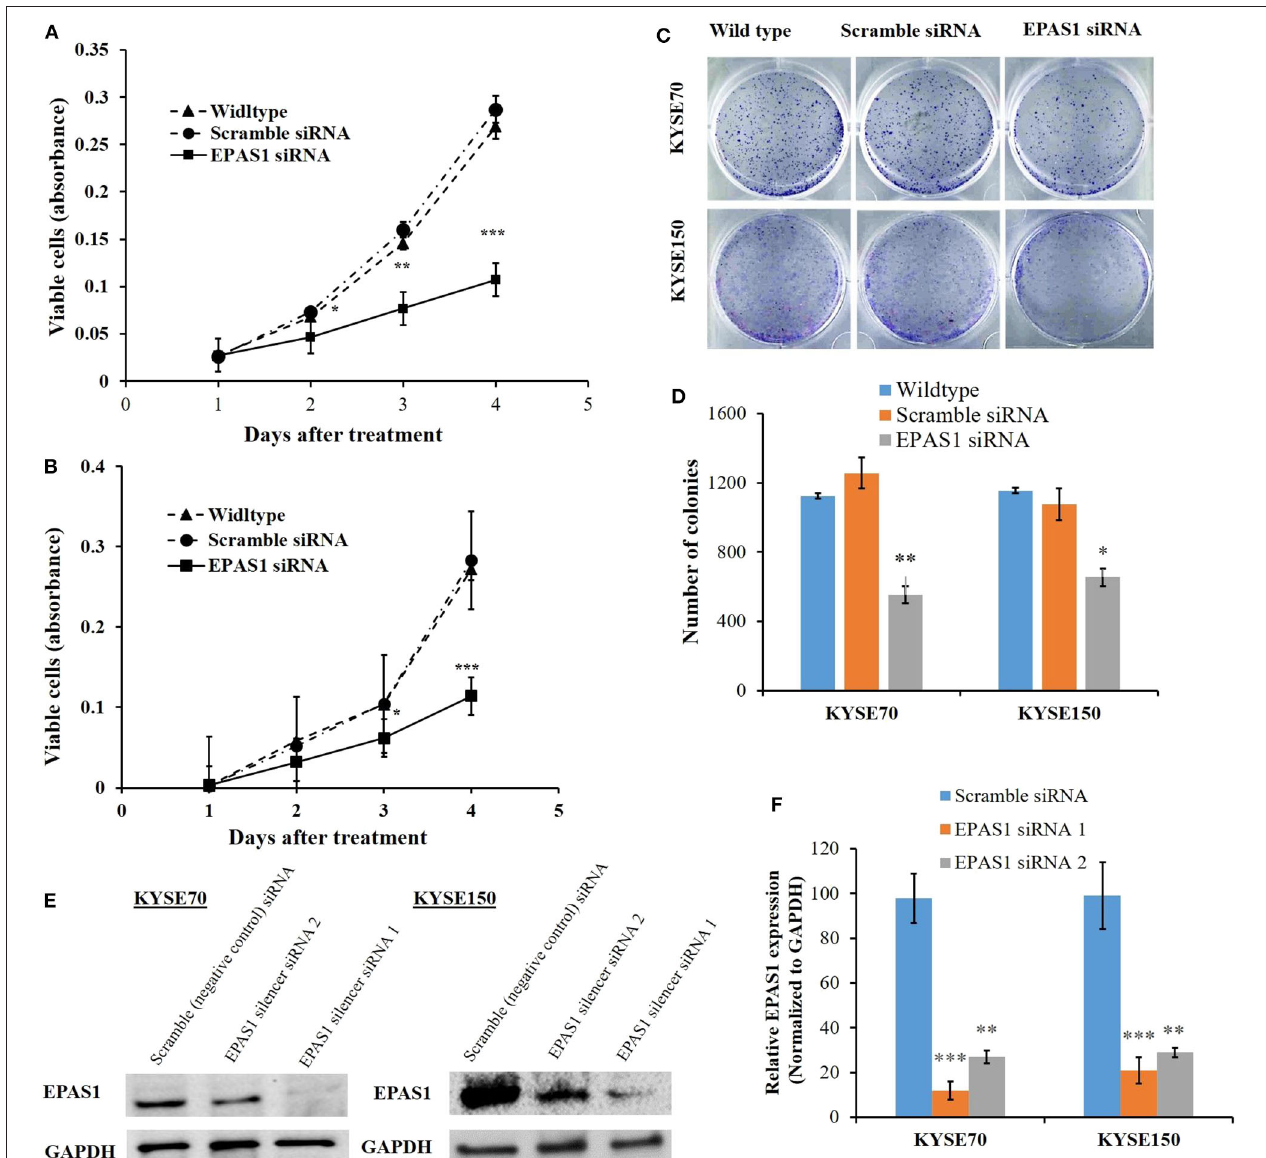
FIGURE 6 | EPAS1 suppression inhibited ESCC cells proliferation and colony formation. in vitro suppression of EPAS1 using siRNA in KYSE70 (A) and KYSE150 (B) cells caused significant reduction in proliferation at different time points when compared with untreated and scramble control cell groups. In addition, silencing of EPAS1 induced significant reduction of colony formation capacity KYSE70 (C) and KYSE150 (D) cells in comparison to that of control groups. (E) Expression of EPAS1 protein in KYSE70 and KYSE150 cells followed by siRNA treatment. (F) Relative expression of EPAS1 in KYSE70 and KYSE150 cells followed. EPAS1 siRNA1 ans siRNA2 significantly inhibited the expression of EPAS1 in KYSE70 and KYSE150 cells. Results are shown as mean ± SD and significance level was taken at p < 0.05. * p < 0.05, ** p < 0.01, and *** p < 0.001.